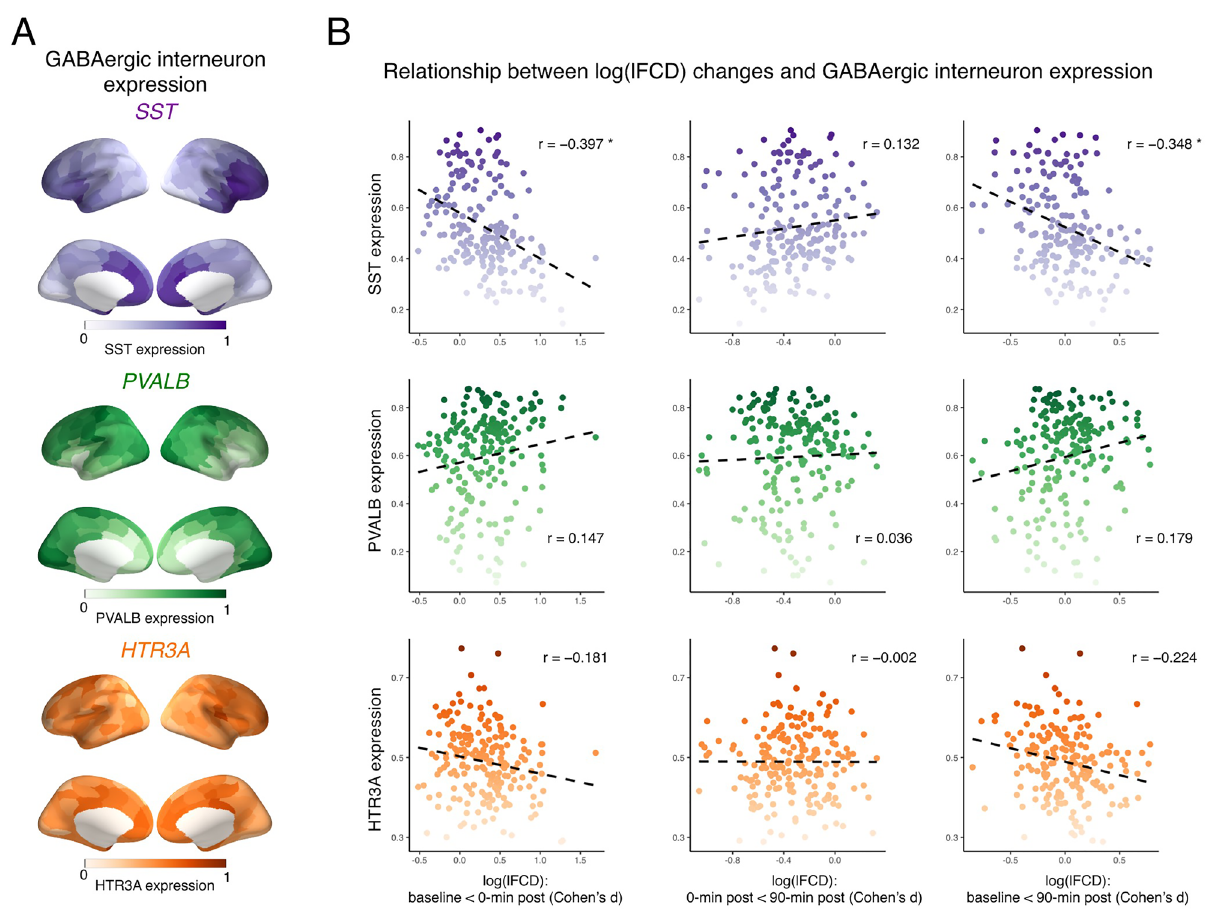
Figure 2. Correlation between alcohol-induced changes in functional connectivity and cortical expression maps specific to GABAergic interneuron subtypes. Panel ( A ) shows distributions of cortical expression of each GABAergic interneuron subtype. These cortical expression data are visualized using pysurfer (0.10) (https:// github. com/ nipy/ PySur fer). Panel ( B ) shows spatial relationships between log(lFCD) changes across conditions and cortical gene expression specific to each GABAergic interneuron subtype. *P FDR < 0.05. HTR3A 5-hydroxytryptamine 3a receptor, lFCD local functional connectivity density, GABA gamma-aminobutyric acid, PVALB parvalbumin, SST